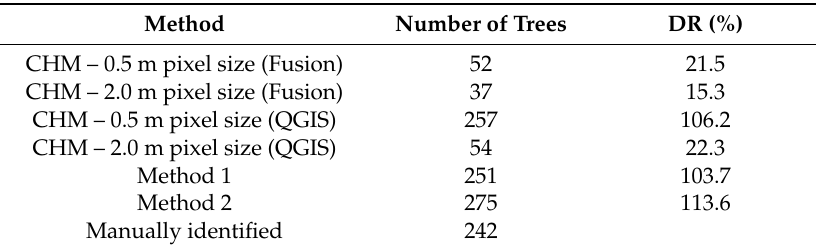
Table 4. Stem counting on a set of rows of trees.